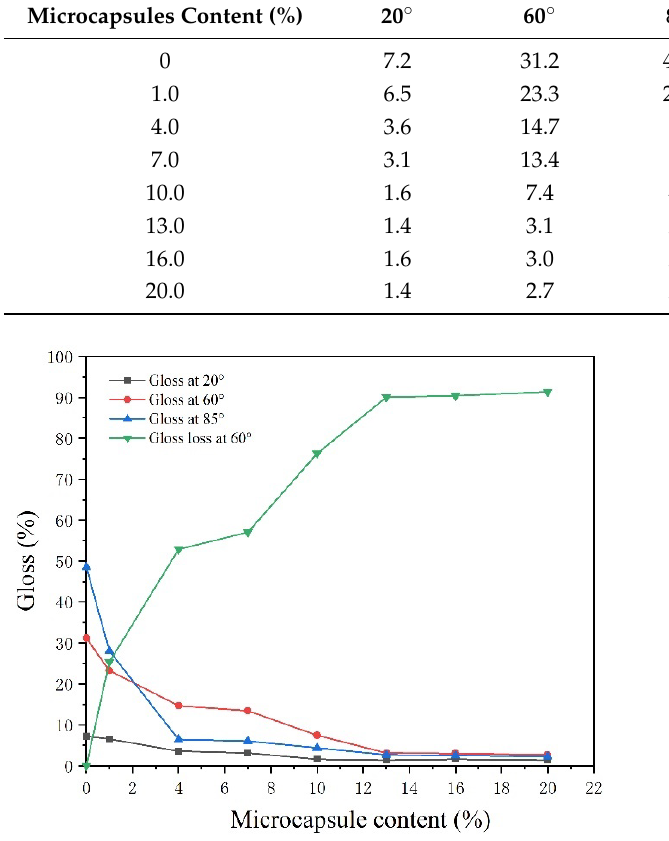
Figure 7. Effect of the microcapsule content on gloss of the coatings.